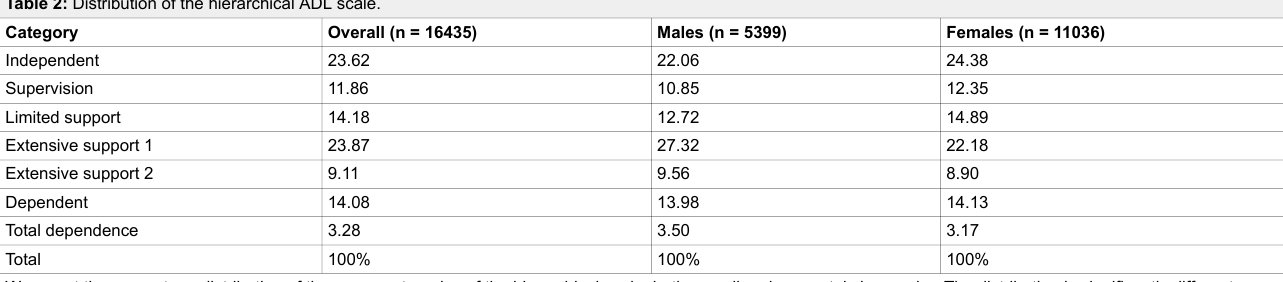
Table 2: Distribution of the hierarchical ADL scale.